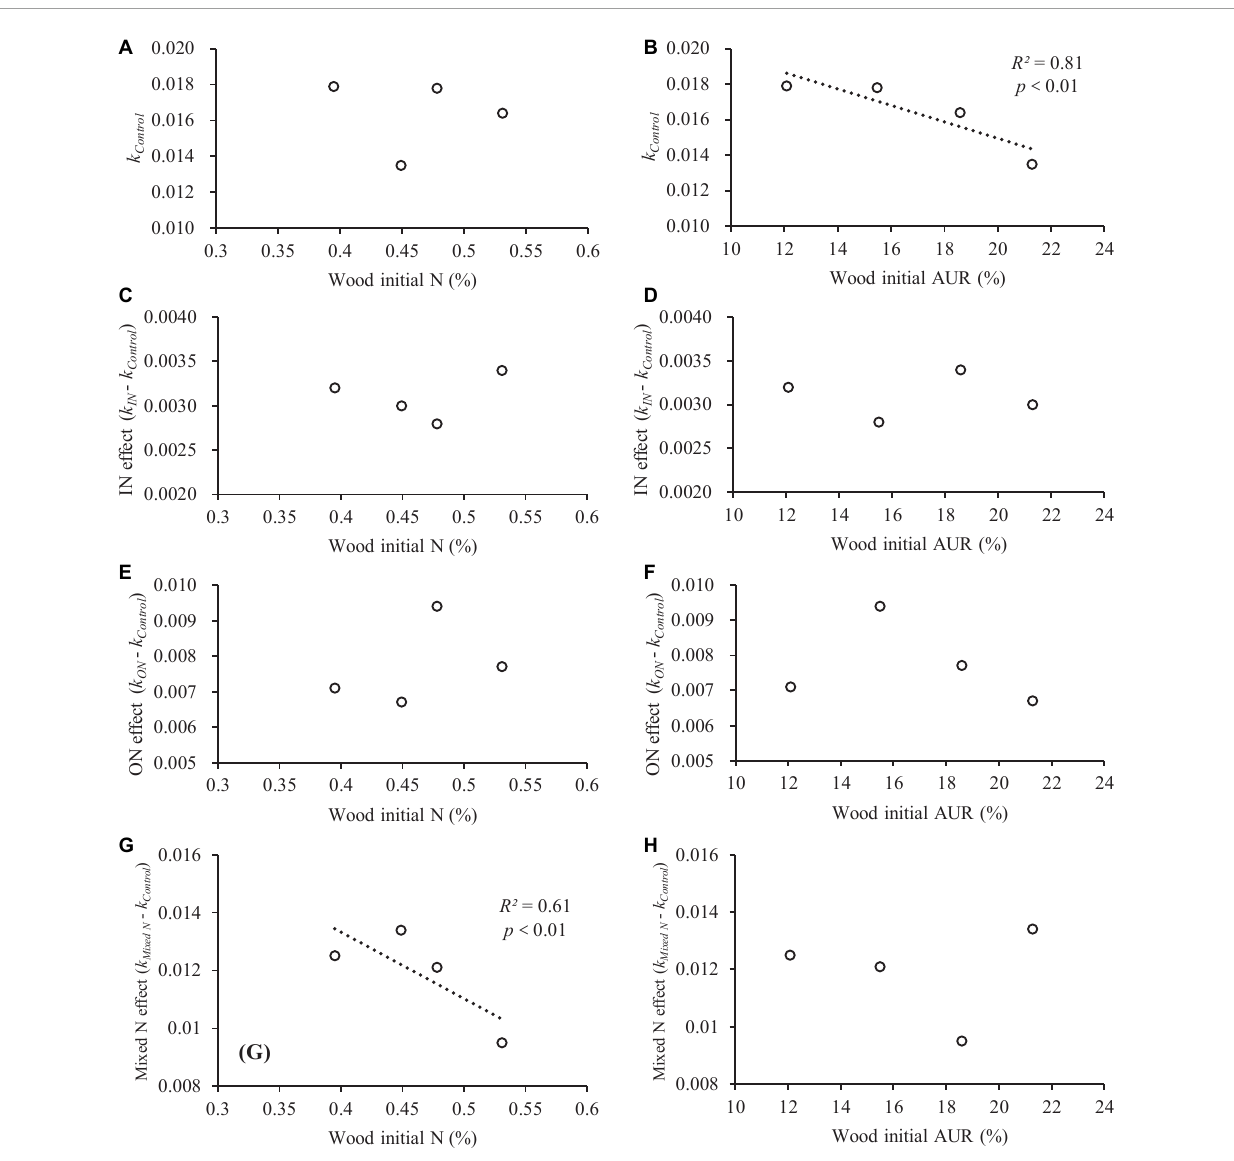
FIGURE3 The linear regressions ( p < 0.05) between the initial wood N and AUR concentrations and different forms of N fertilizer (average of six replicates for the four studied species). (A–H) Represent the linear regressions between kControl, N effect (kIN - kControl), ON effect (kON - kControl), Mixed N effect (kMixed N - kControl) and wood initial N (%), and wood initial AUR (%), respectively.